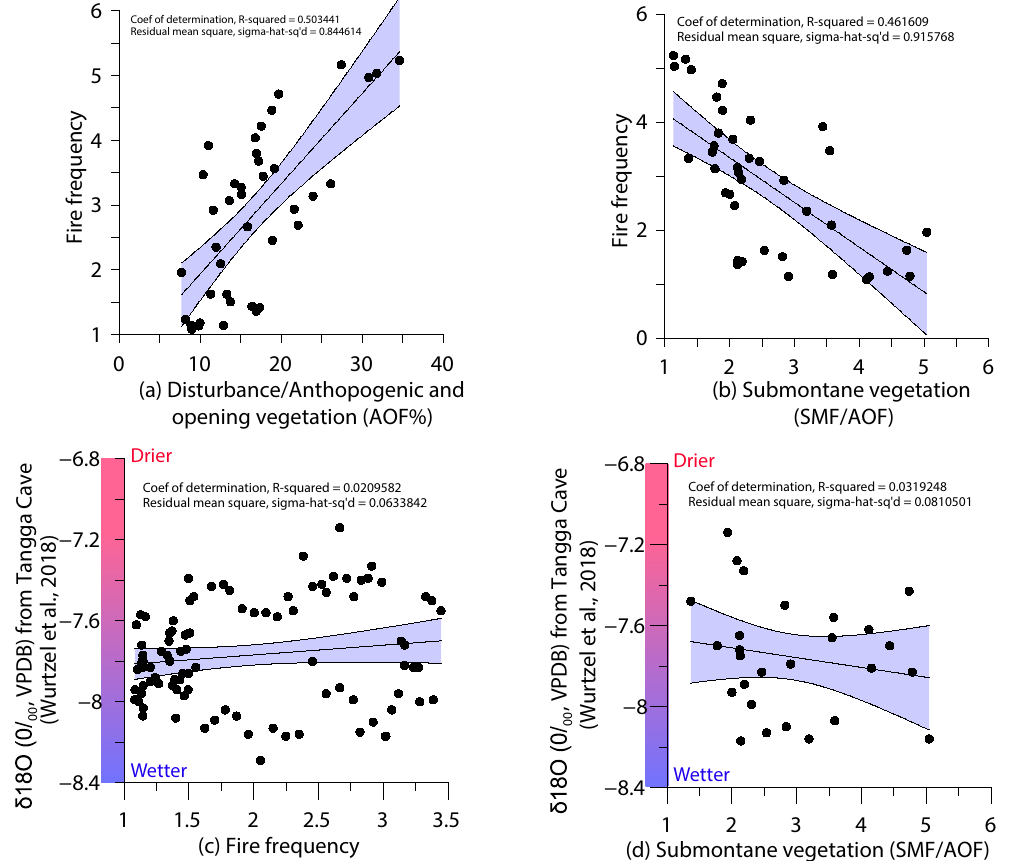
Figure 7. Fitted simple linear regression to model the relationship between ( a ) fire frequency vs. disturbance/anthropogenic and opening vegetation (AOF%). ( b ) Fire frequency vs. submontane vegetation (SMF/AOF). ( c ) Fire frequency vs. paleo-precipitation record. ( d ) Vegetation paleo- precipitation record. Variables used: Fire frequency from CharAnalysis [46], paleo-precipitation data from Tangga Cave [19], and vegetation from palynological data in